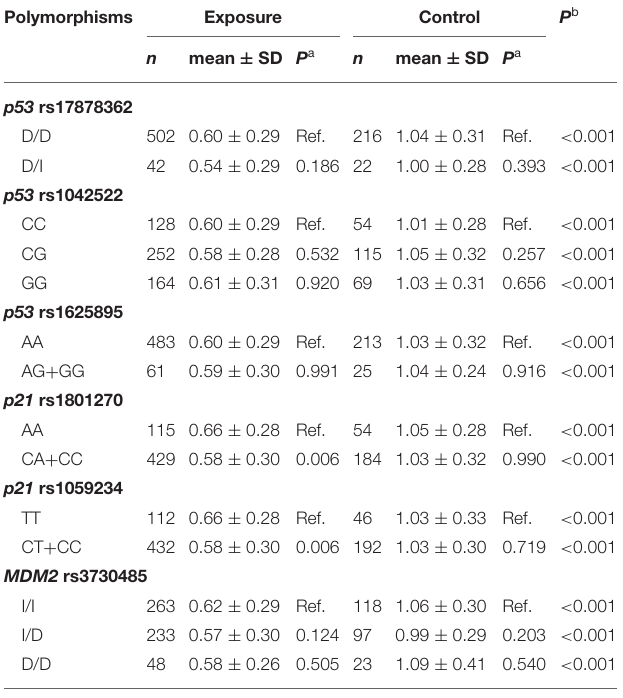
Ref., The reference group of pairwise comparison, using Least Significant Difference test. MtDNA, Mitochondrial DNA. a The covariance analysis was applied to analyze the difference of mtDNA copy number between genotypes, adjusted for gender, age, smoking status, drinking status, and body mass index. b ThettestwasperformedtocomparethemtDNAcopynumberbetweenexposuregroup and control group in genotype